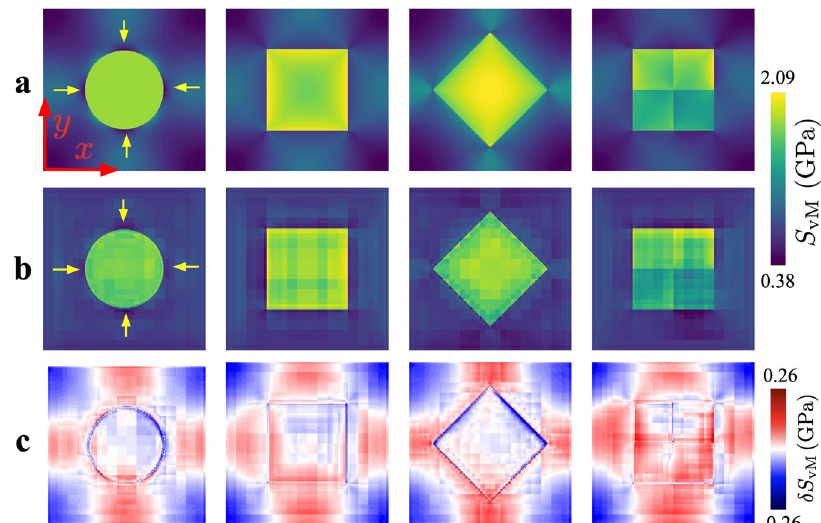
Fig. 3 Predicted stress distribution for selected geometries beyond the trained topologies. Simulation results ( a ) for isotropic elastic material response for topological cases far away from the trained set of Voronoi structures and the corresponding AI predicted ( b ) von Mises stress distribution for different hard inclusions in a soft matrix. The error between the AI prediction and the DAMASK solution is shown in ( c